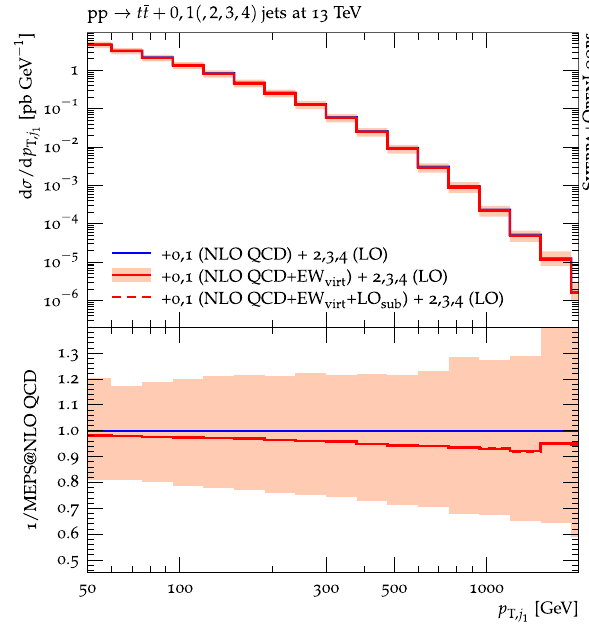
Fig. 4 Leading jet transverse momentum distribution at the LHC with 13 TeV comparing MePs@Nlo QCD and MePs@Nlo QCD + EW virt parton-level predictions. Error bands are due to QCD scale variations